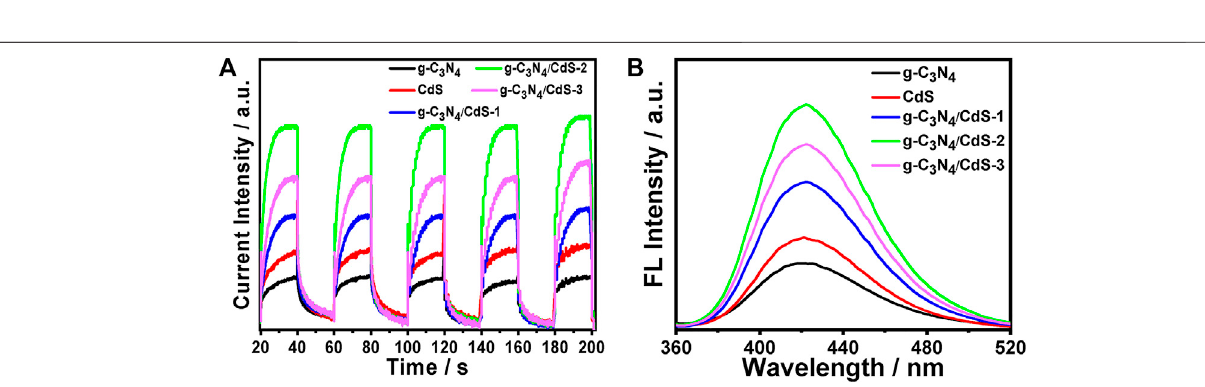
Frontiers in Chemistry |